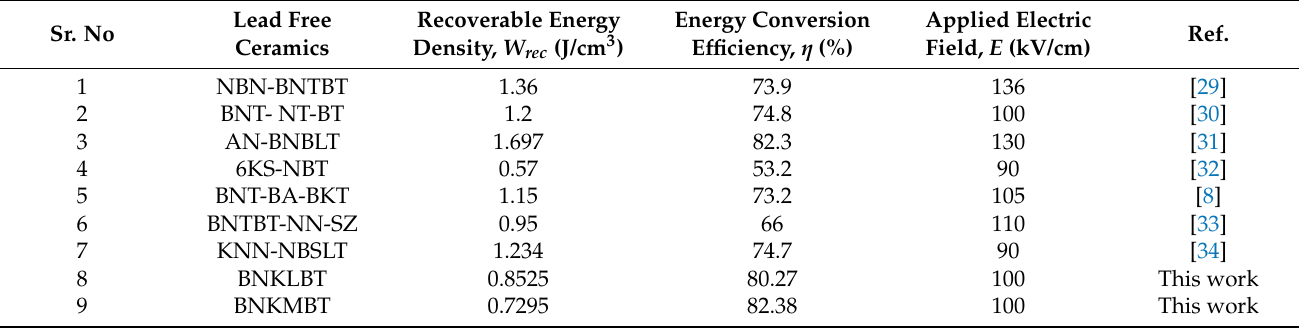
Table 3. Energy Storage comparison study of BNKLBT and BNKMBT ceramics with other reported high entropy